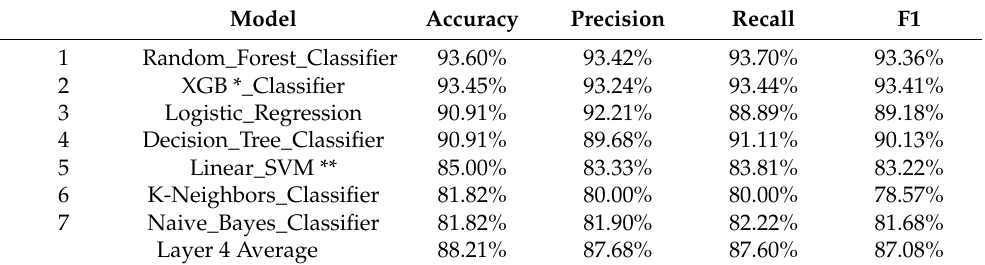
Table 7. Layer 4—accuracy.